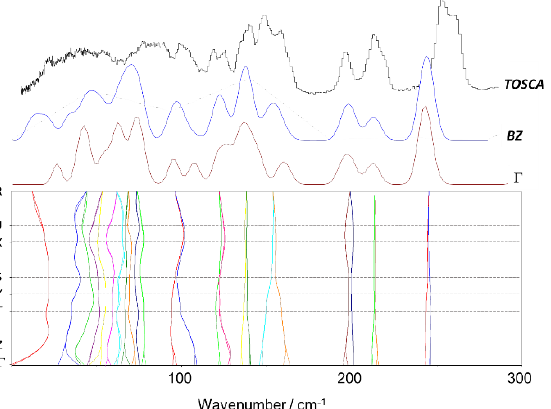
Figure 6. Experimental and calculated (“fixed cell”) INS spectra of 4EtOB in the range below 300 cm − 1 . Bottom panel: calculated phonon dispersion relations along the high symmetry points; top lines: comparison between the INS spectra calculated at the Γ -point ( Γ ), averaged by the dispersion throughout the Brillouin zone (BZ), and experimental INS spectrum (Tosca).